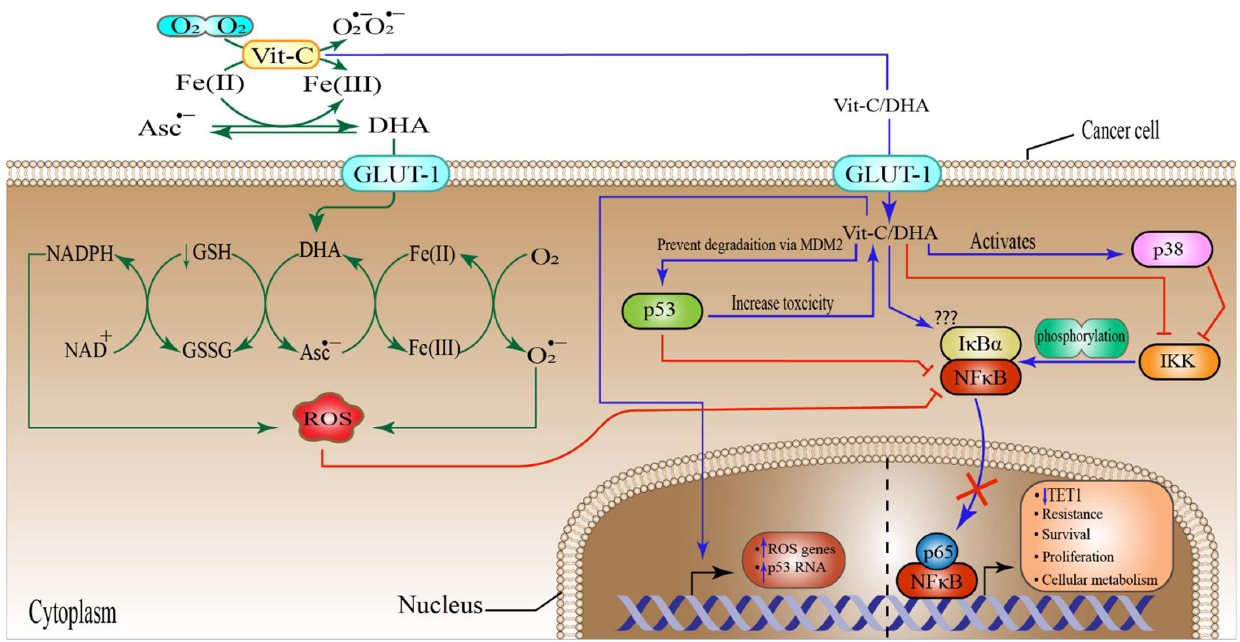
Figure 4. High-dose Vit-C targeting the NF-κB . High-dose Vit-C can generate massive amounts of ROS through the Fenton reaction and Haber–Weiss reaction by recycling Cu(II)/Cu(I) and Fe(II)/Fe(III), which in turn inhibits the NF-κB. Vit-C can also increase the expression of genes that produce p53 and ROS, in addition to activating and protecting p53 from degradation by MDM2, after which the activated p53 can inhibit the NF-κB and increase Vit-C toxicity. Vit-C can directly inhibit IKK and activate p38, which in turn blocks IKK, which releases NF-κB from IκBα by phosphorylation. If the NF-κB is successfully activated, it can initiate cancer growth and development via various pathways. Vit-C, vitamin C; MDM2, Mouse double minute 2; ROS, reactive oxygen species; IKK, IκB kinase.